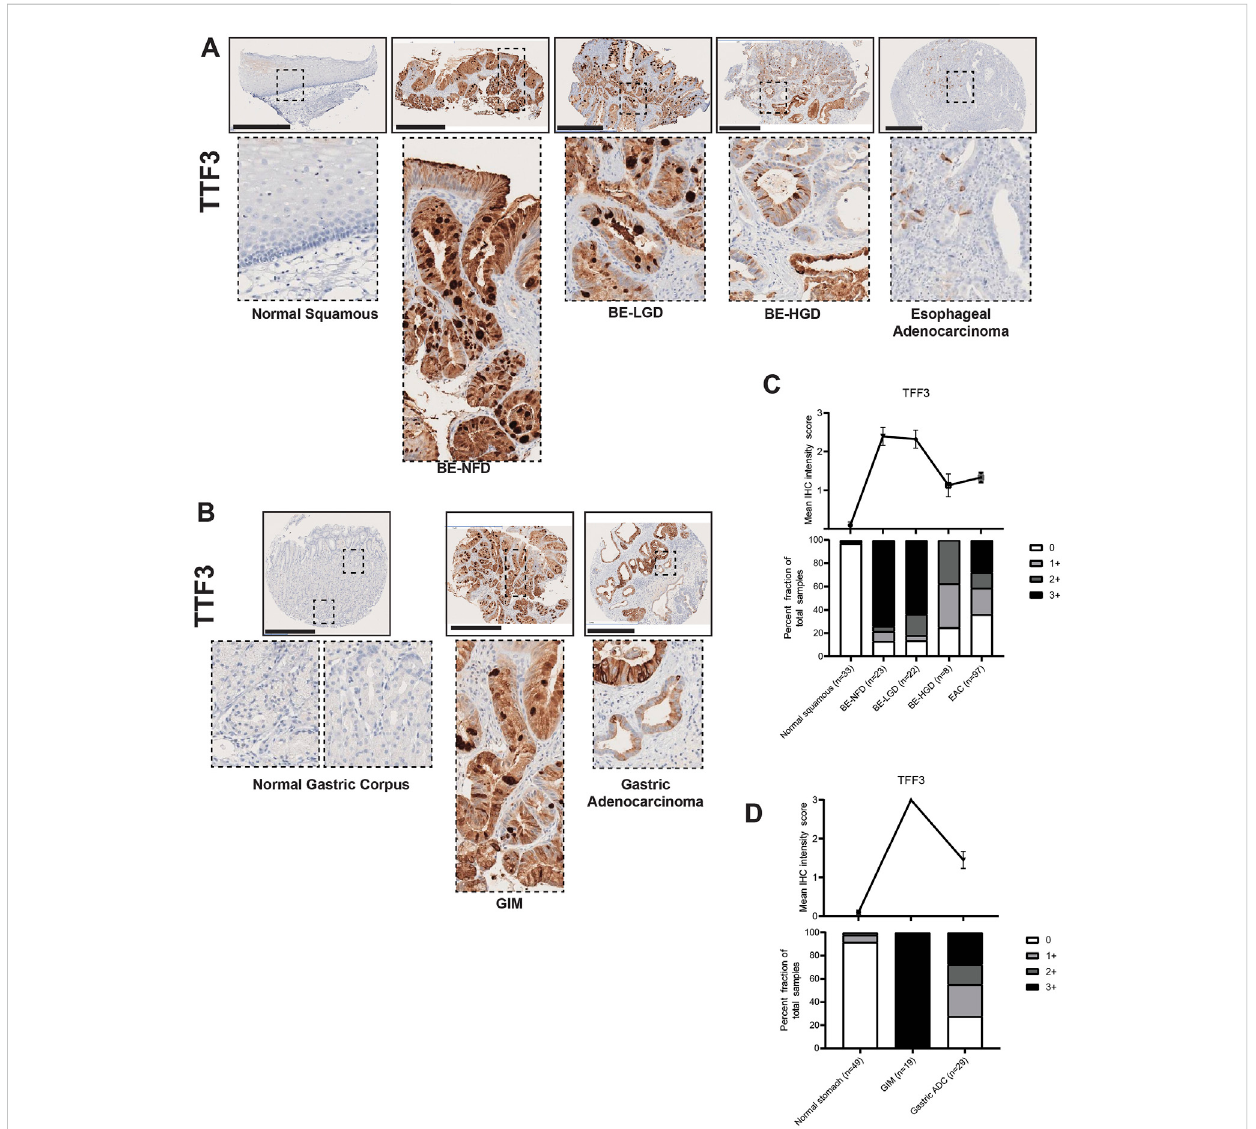
FIGURE 3 TFF3expressioninnormalsquamous-BE-EACandnormalgastricgland-GIM-GAprogressionsequence. (A) ImmunohistochemistryofTFF3staining in human tissue microarray esophageal cases, in the same sequence as in Figure 2A. (B) Immunohistochemistry of TFF3 staining in human tissue microarray gastric cases, in the same sequence as in Figure 2B. All scale bars, 500 μ m. (C) Top: the TFF3 average IHC intensity score of each esophageal phenotype is plotted in the same sequence as in Figure 2C. Bottom: the TFF3 fraction of esophageal tissue cores with each score is plotted in the same sequence as in Figure 2C. Each phenotype ’ s total tissue core number is provided at the bottom of each column. (D) Top: the TFF3 average